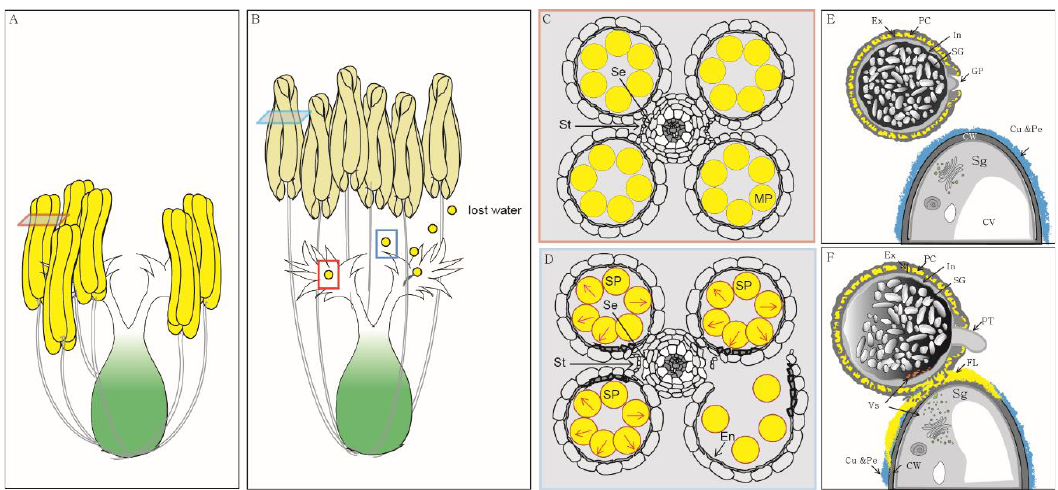
Figure 1. Schematic representation of a rice flower. ( A ) Flower before anthesis; ( B ) flower at anthesis; ( C ) Transverse image of an anther at the mature stage; ( D ) transverse image of an anther at anthesis. Rapid pollen swelling is the driving force behind the rupture of the anther wall. Red arrows indicate the pressure caused by swollen mature pollen grains; ( E ) pollen before landing on the stigma; ( F ) pollen after landing on the stigma. The pollen coat is mobilized on the stigma to form a “pollen foot” in rice. Numerous membranous inclusions appear on the stigma. The illustration of structural changes that occur at the point of adhesion between pollen and stigma is based on observations from Arabidopsis . Cu & Pe—cuticle and proteinaceous pellicle; CV—central vacuole; CW—cell